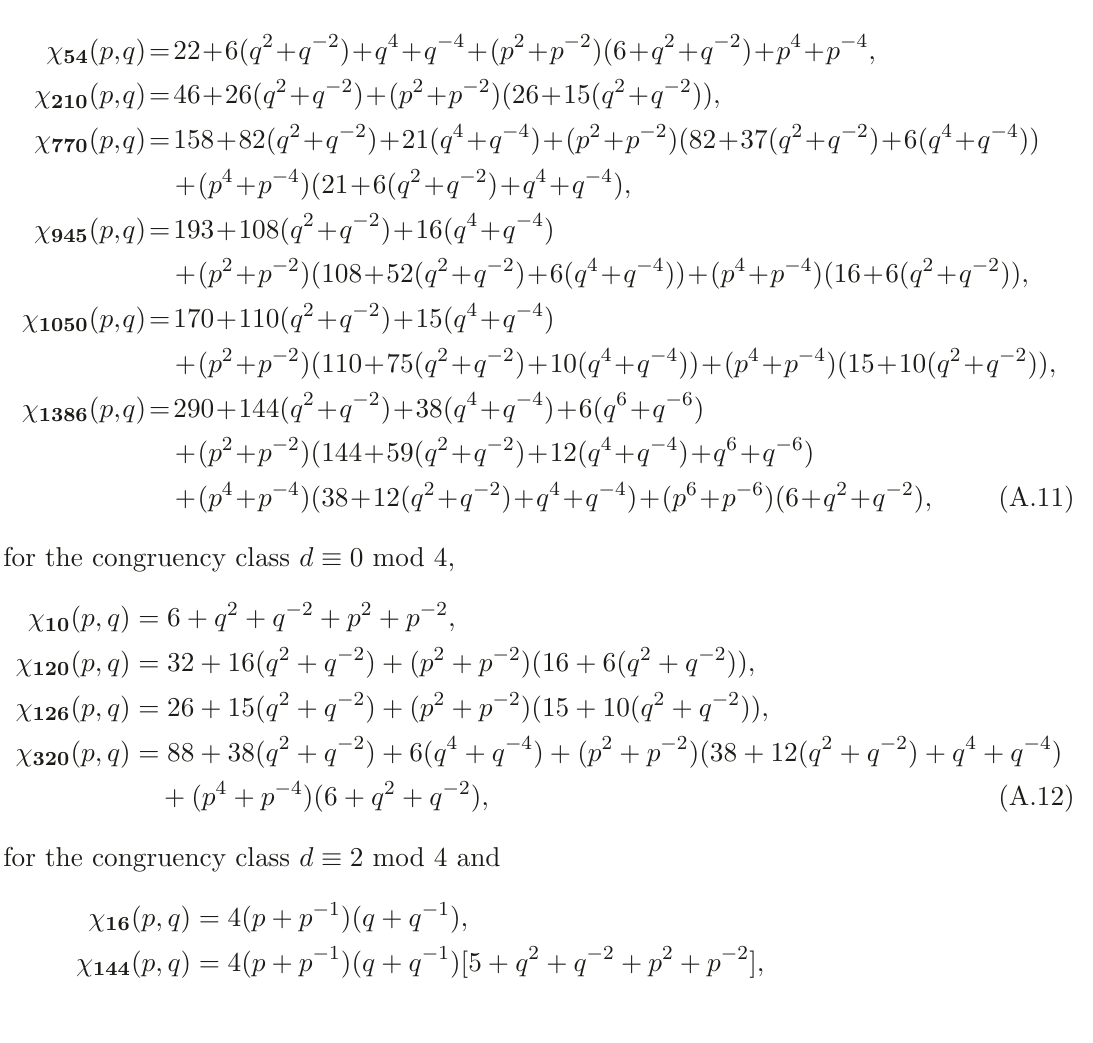
Table 7 . (Left two) The alternating BPS indices ( − 1) d − 1 N in the congruency class d ≡ 0 or d ≡ 2 mod 4 which are used in the membrane instanton effects β ′ for d = 2 , 4 , 6 , 8. (Right one) The weighted BPS indices ( − 1) d − 1 M ( d,d m ) so(10) in the congruency class d ≡ 1 or d ≡ 3 mod 4 which are used in the membrane instanton effects γ d ( k ) for d = 1 , 3 , 5 ,